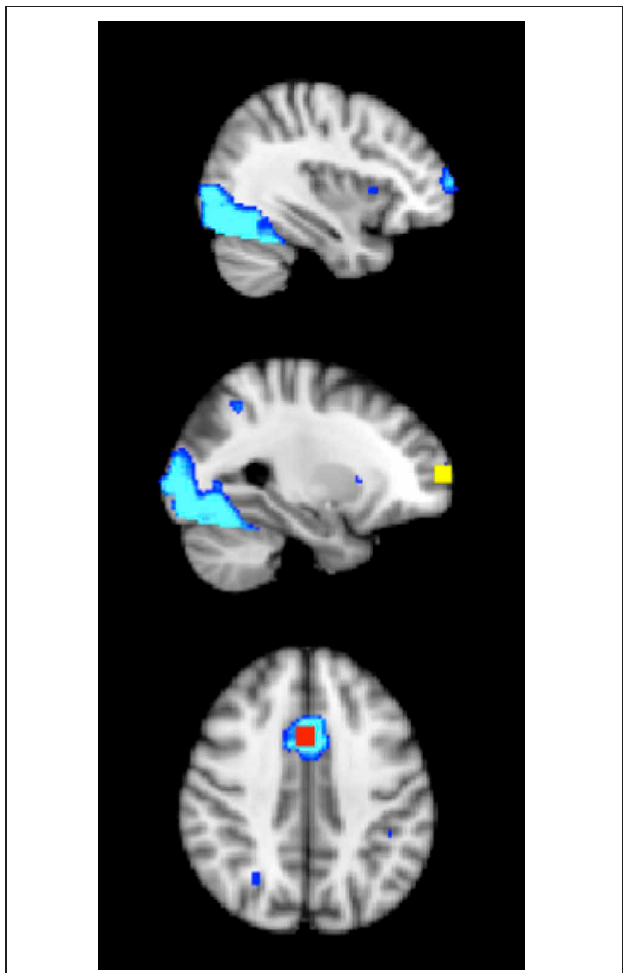
FIGURE 2 | The 8mm (diameter) box ROIs (1000 mm 3 ) in the frontal cortex, derived from an average activation map during incongruent, neutral and NoGo conditions of the task of cognitive control, across both physical activity and control child groups at pre-test and post-test (thresholded at Z > 6). Right anterior prefrontal cortex = yellow; ACC = red; average activation map =